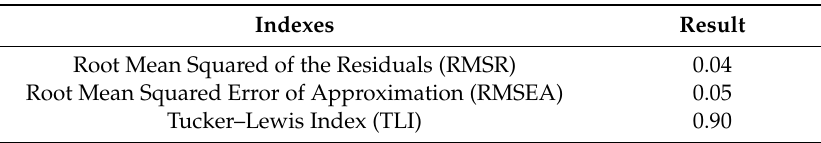
Table 5. Fit indexes for the proposed factor